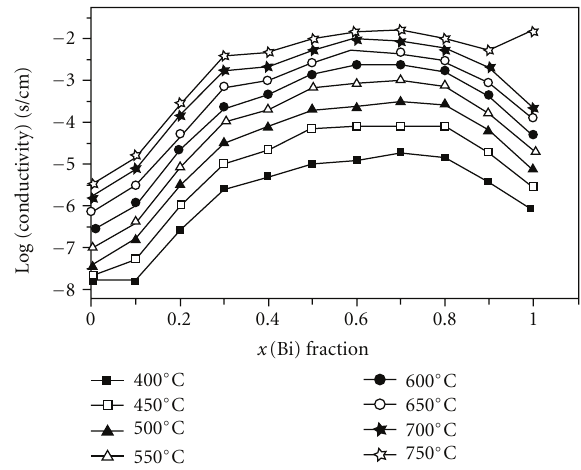
Figure 6: Evolution of sample conductivity for the system (1 − x )CeO · ( x/ 2)Bi 2 2 O 3 as a function of composition temperatures. The monoclinic transition is observed between 700 and 750 ◦ C in the diagram ( x = 1) with a large log( σ )